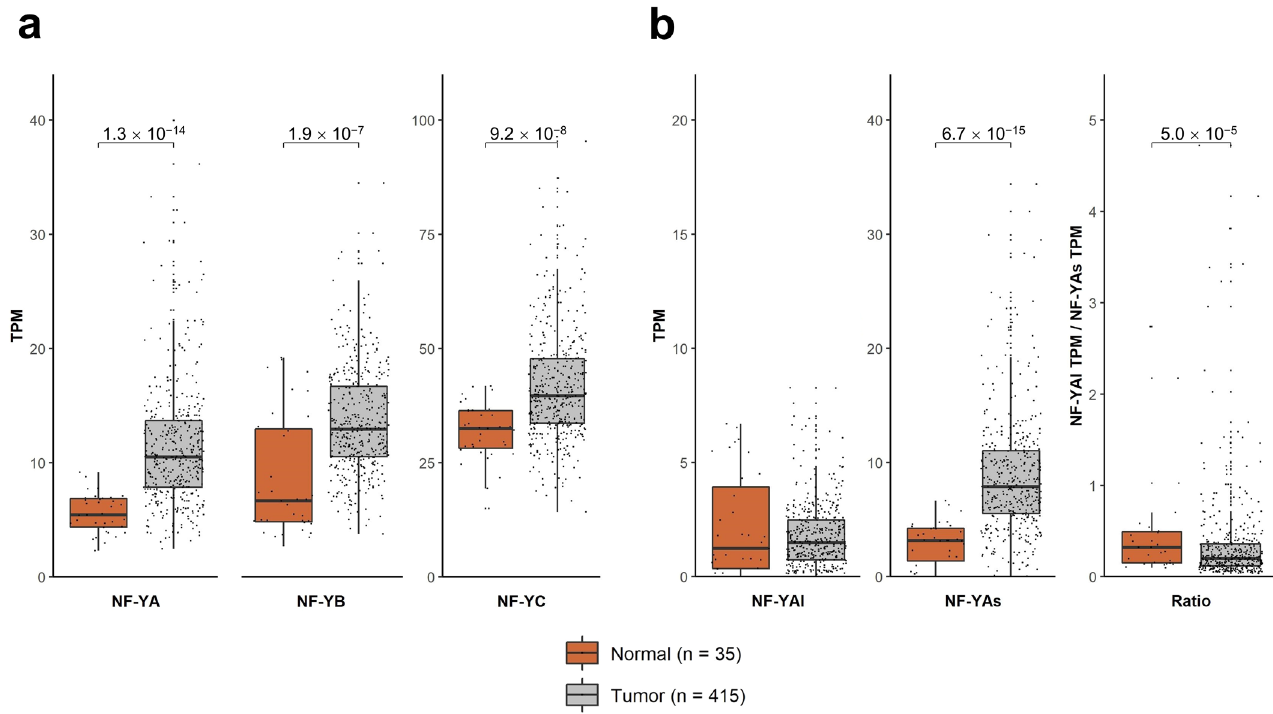
Figure 1. NF-Y subunits are overexpressed in STAD. ( a ) Box plots of expression levels of the three NF-Y subunits at gene level in the TCGA-STAD dataset, measured in TPMs. ( b ) Same as ( a ) with the analysis of the NF-YA, -NF-YAs, NF-YAl-isoforms levels as well as the NF-YAl/NF-YAs ratio. p values are calculated using the Wilcoxon rank-sum